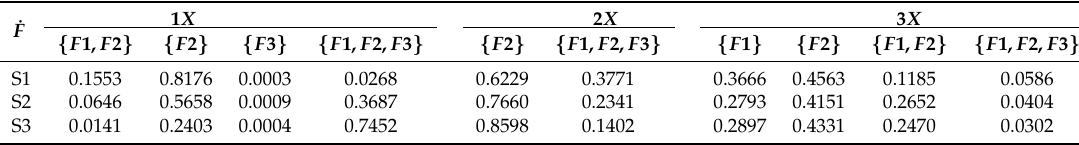
Table 9. The obtained